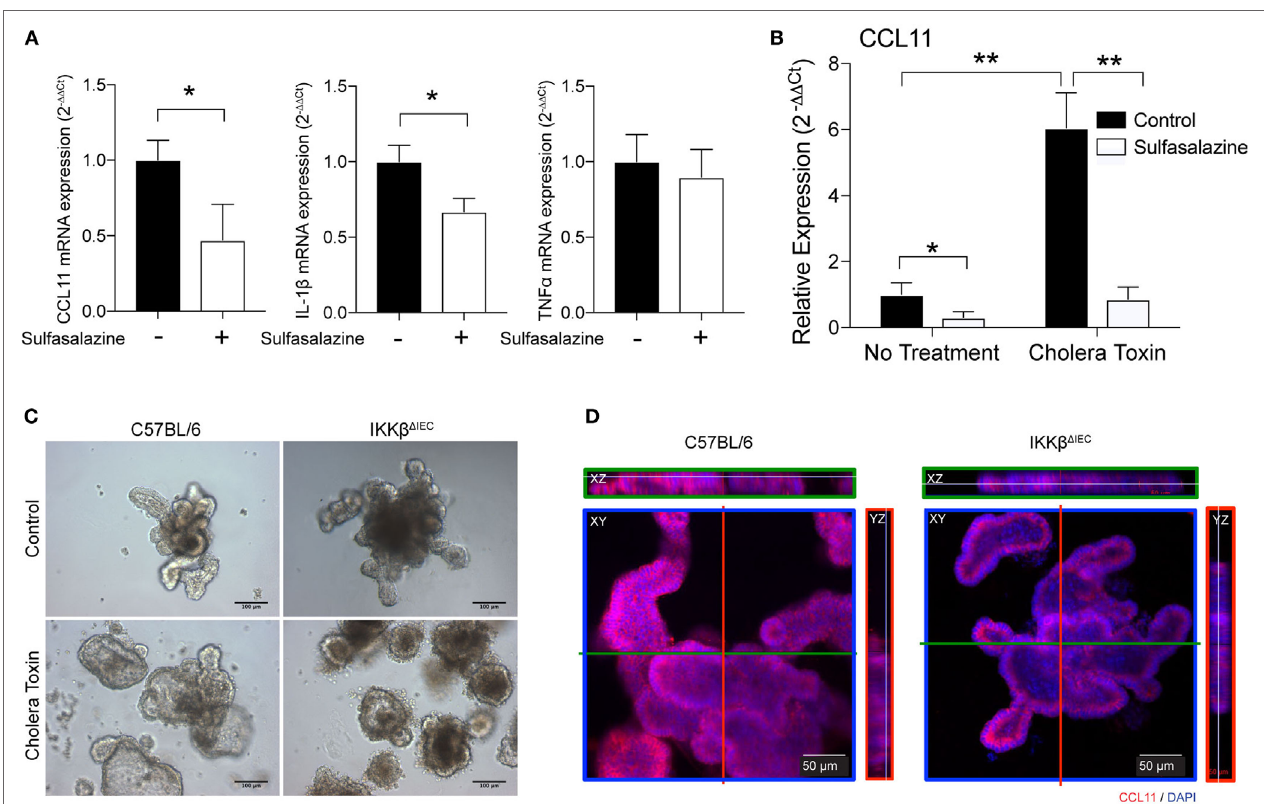
FigUre 5 | CLL11 expression in human epithelial cells and organoids of wild-type and IKK β Δ IEC mice. (a,B) The human HT-29 epithelial cells were cultured in the absence or presence of sulfasalazine, a specific pharmacological inhibitor (50 µM) of the canonical NF- κ B pathway, without (a) or with (B) stimulation with